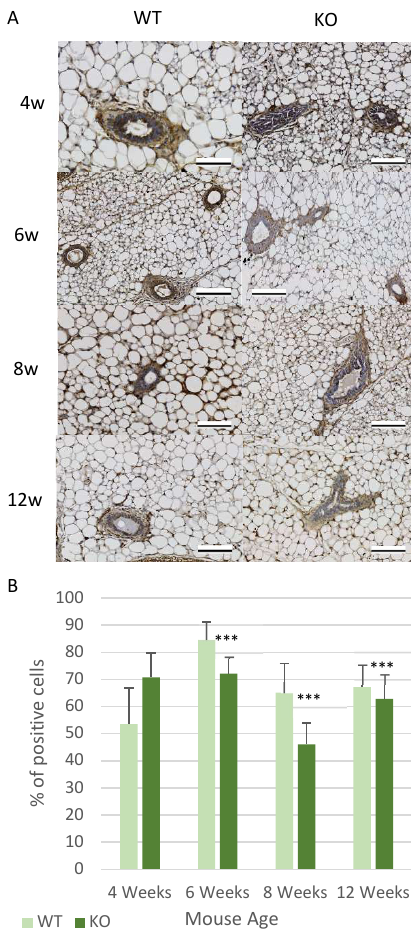
Figure 7. Loss of Csmd1 causing changes in the expression patterns of Pi3k/Akt signaling. ( A , B ) Akt expression analysis. ( A ) Images showing the amount of positive Akt expression in the mammary gland ducts at all ages in the WT and KO mice, using IHC staining. ( B ) The graph shows the average percentage of cells which are positively expressing Akt in each duct (*** p < 0.001). The numbers of animals for each time point included ( n = 6 WT; n = 6 KO), 6-week-old mice ( n = 8 WT; n = 7 KO), 8-week-old mice ( n = 7 WT; n = 7 KO), 12-week-old mice ( n = 7 WT; n = 7 KO). All images were taken using an x40 objective, with all scale bars 100 µm.